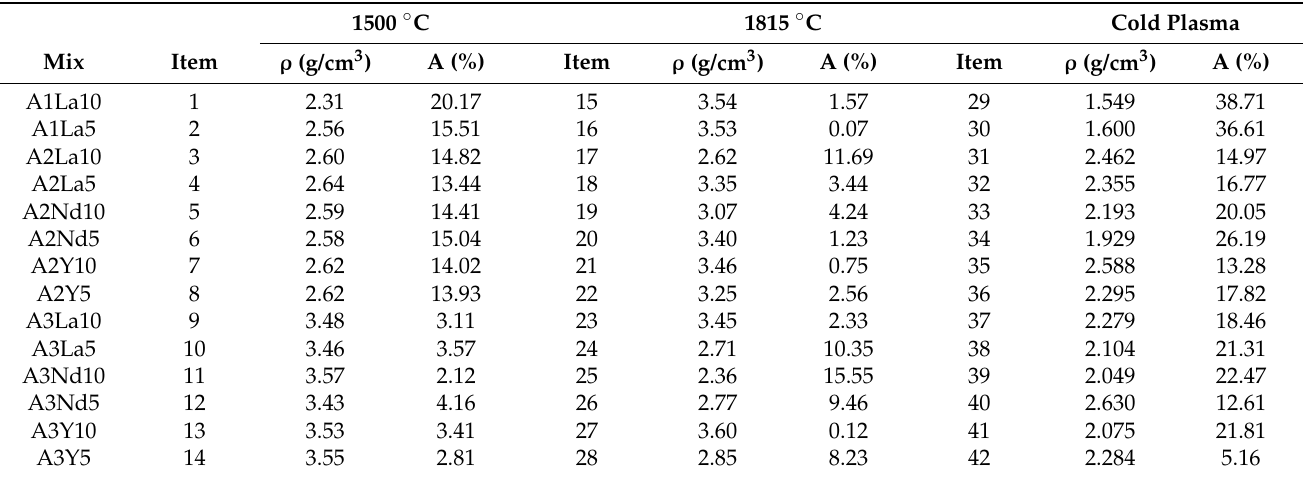
Table 2. Ceramic properties ( ρ and A) recorded at 1500 ◦ C, 1815 ◦ C, cold